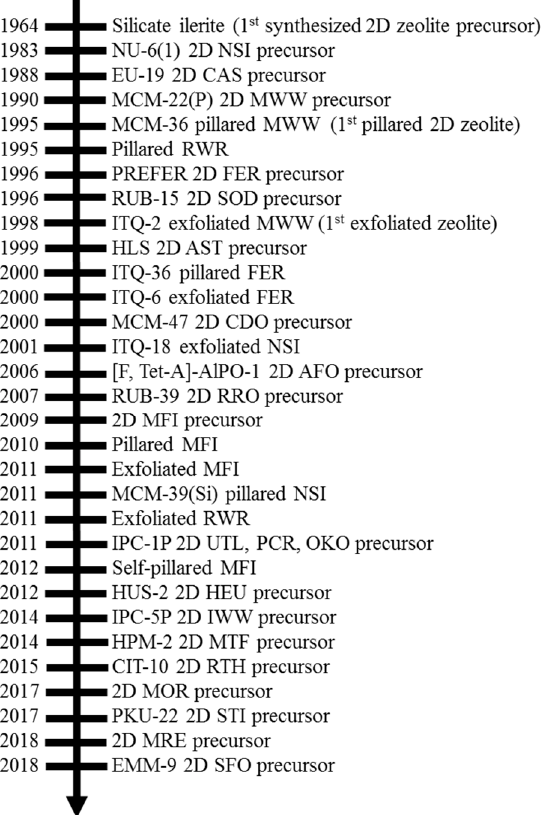
Figure 1. Timeline of the development of 2D layered zeolite precursors and their derivatives.